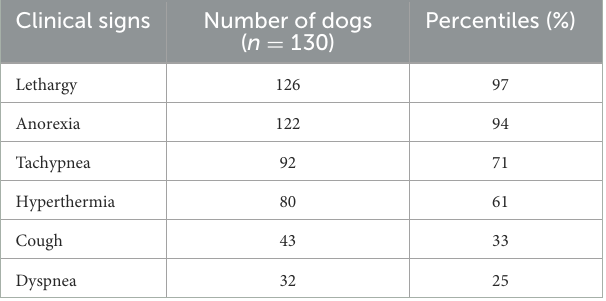
TABLE 1 Main clinical signs observed in dogs with bacterial pneumonia at